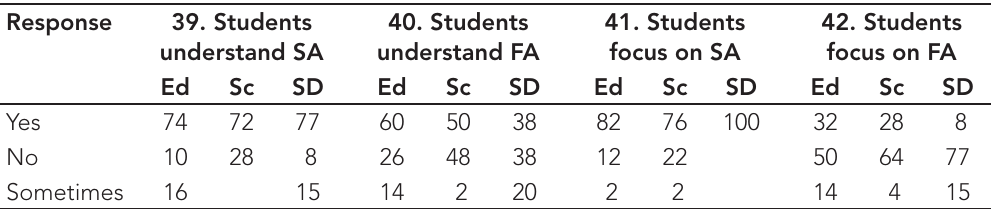
Table 16: Students understand and focus on summative and formative assessment